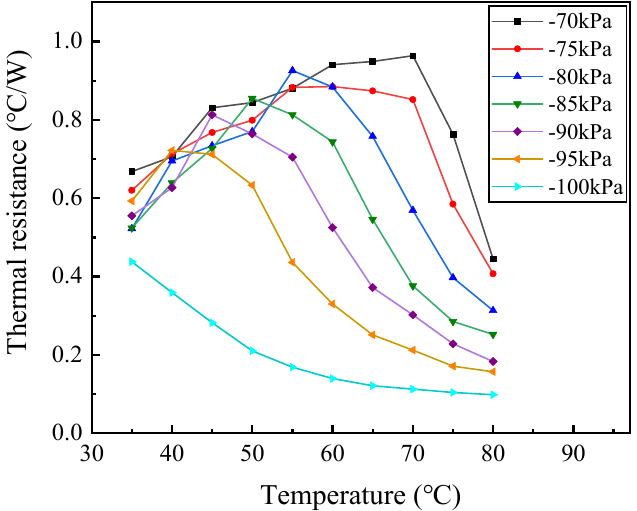
Figure 4. Thermal resistance versus temperature at different vacuum degrees.